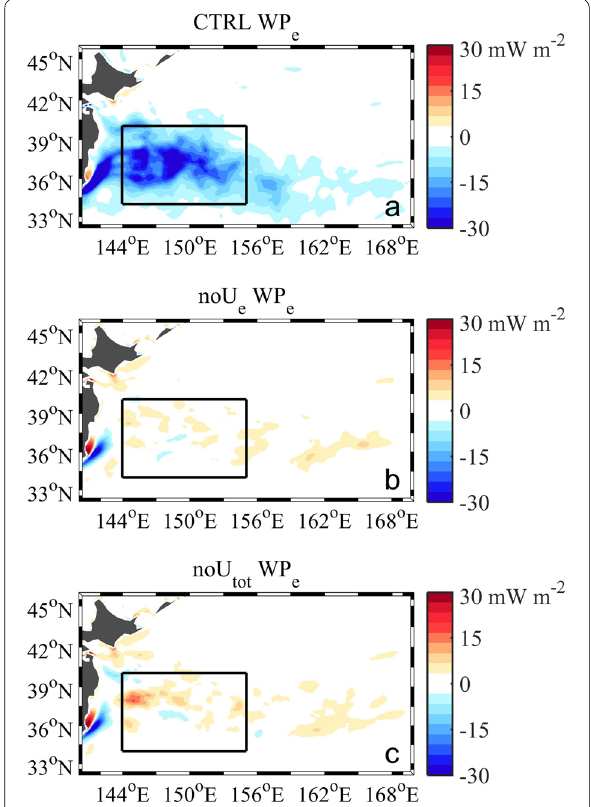
Fig. 3 The 5-year wintertime mean wind power input to mesoscale eddies in a CTRL, b noU e and c noU tot . The boxes denote the Kuroshio extension